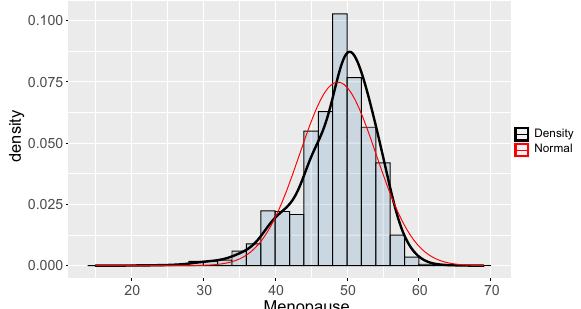
Figure 1. Age at menopause. The variable has a left (negative) skewed distribution.